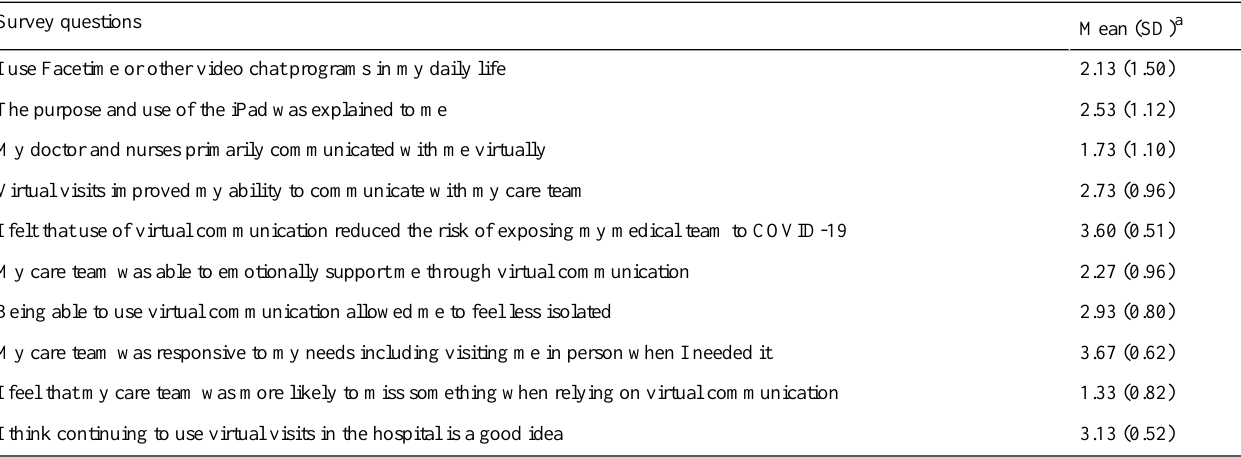
Table 3. Patient satisfaction: means and distributions of survey responses of patients with